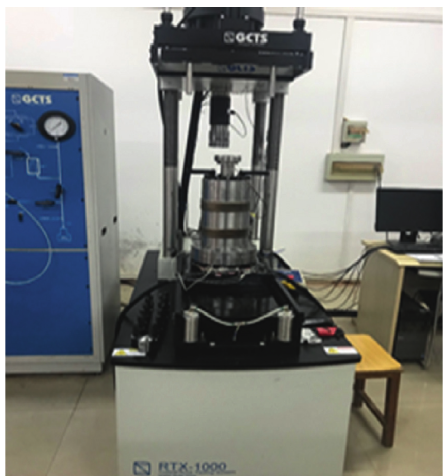
Figure 1: RTX-1000 high-temperature and high-pressure dynamic rock triaxial instrument.